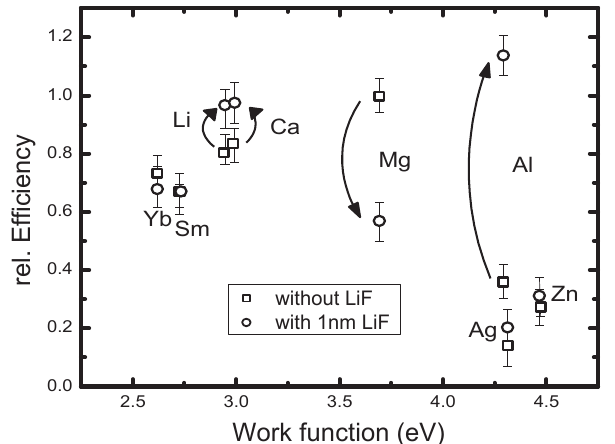
Figure 3. Effect of interlayer with a variety of cathodes for relative efficiency for a LiF interlayer. Adapted from Ref. [83] copyright (2000) with permission from